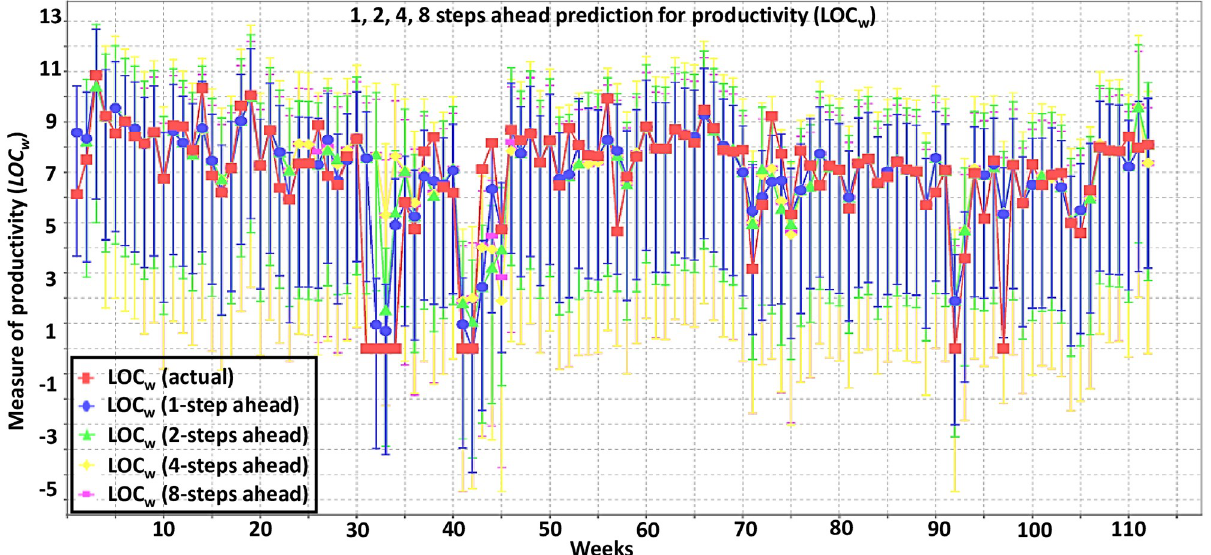
Fig 5. 1, 2, 4, 8 steps ahead prediction for productivity ( LOC